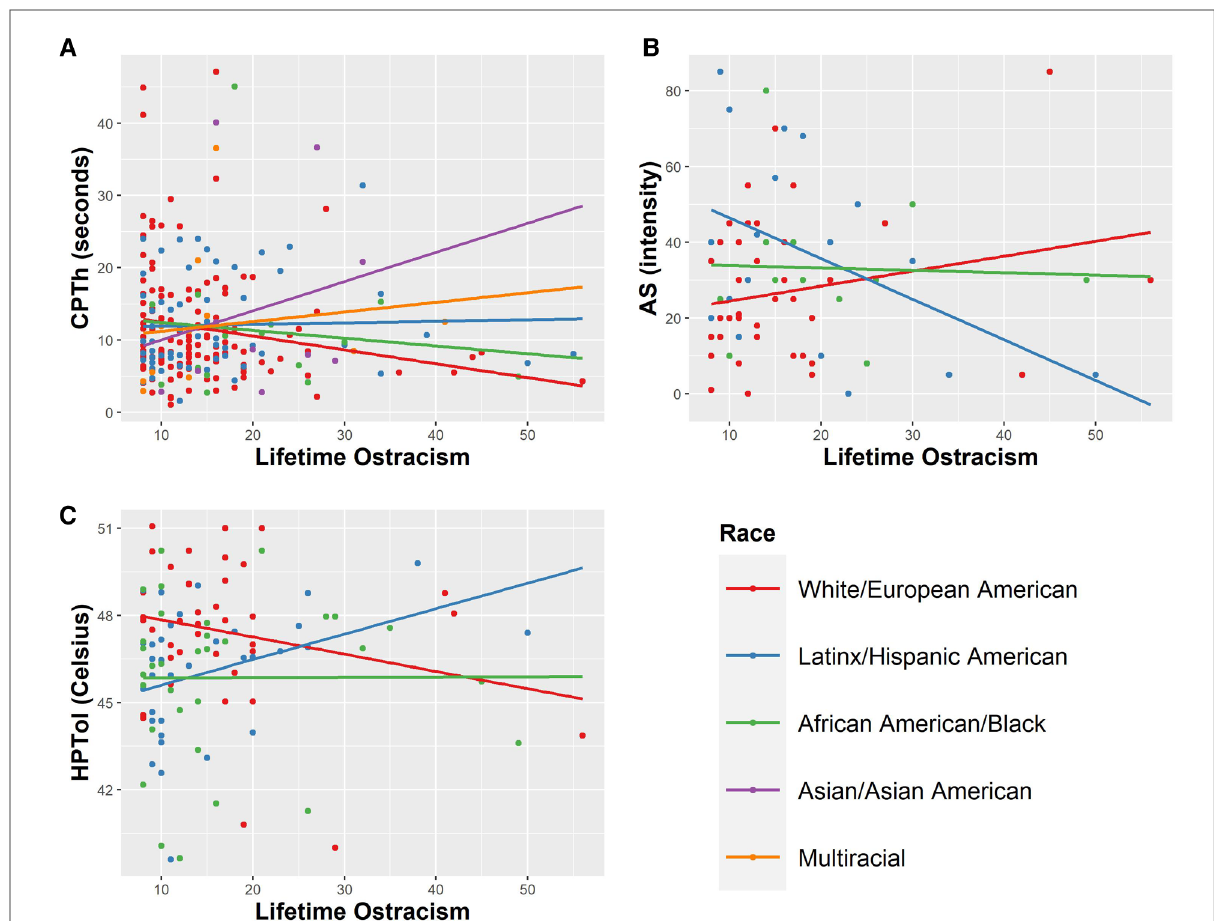
FIGURE 3 Racialized identity signi fi cantly ( p <0.05) moderated the relationship between ( A ) cold pain threshold (CPTh sec ), ( B ) after sensations 30 s after cold stimulus cessation ( A S intensity ), and ( C ) heat pain tolerance (HPTol °C ). The raw, untransformed values are presented in the fi